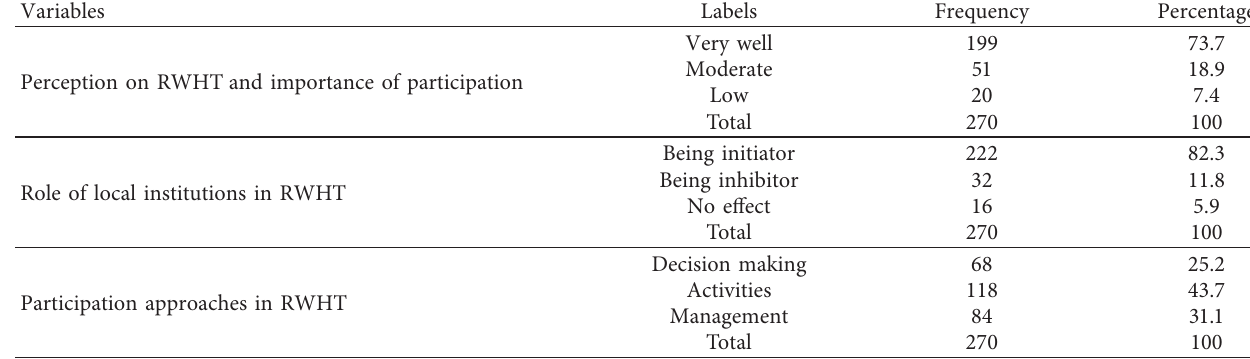
Table 2: Subdistrict households’ perception towards water harvesting technology and their level of participation. Variables